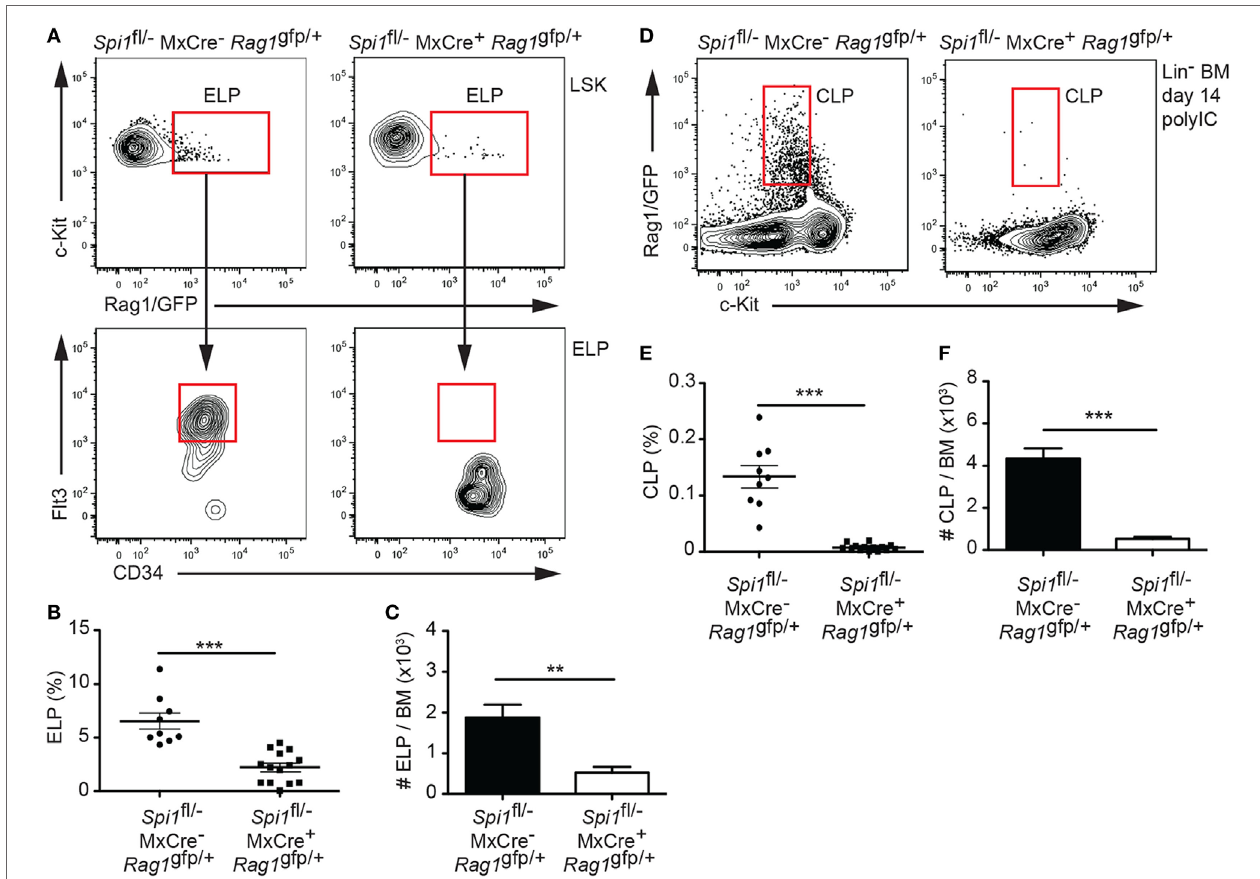
FigUre 2 | Absence of lymphoid progenitors from PU.1 conditionally deficient bone marrow (BM). Spi1 fl/ − MxCre − Rag1 gfp/ + and Spi1 fl/ − MxCre + Rag1 gfp/ + mice were injected with polyIC on days 0 and 3, and analyzed by flow cytometry on day 14. (a) Upper plots, representative flow cytometry plot of the LSK populations, gated as in Figure 1D , from the mice of indicated genotypes. Boxes indicate the position of the Rag1/GFP + early lymphoid progenitor (ELP) populations. Lower plots, ELPs express Flt3 and CD34 in control Spi1 fl/ − MxCre − Rag1 gfp/ + ELPs, but not in the Spi1 fl/ − MxCre + Rag1 gfp/ + cells, confirming the inactivation of PU.1. (B) Graph shows the proportion of ELPs cells in the LSK cell gate. Each dot represents an individual BM sample. Horizontal line shows the mean ± SD. (c) Absolute ELP numbers in the BM. (D) Representative flow cytometry plot of Lin − BM preparations from the mice of indicated genotypes. Boxes indicate the position of the common lymphoid progenitor (CLP)-equivalent populations using Rag1/GFP. (e) Graph shows the proportion of Rag1/GFP + CLPs cells in the Lin − gate. Each dot represents an individual BM sample. Horizontal line shows the mean ± SD. (F) Absolute Rag1/GFP + CLP numbers in the BM. Data in panels (c,F) are the mean cell number ± SD from between 9 and 14 mice per genotype. p Values compare the indicated groups using an unpaired t -test. ** p < 0.01, *** p <